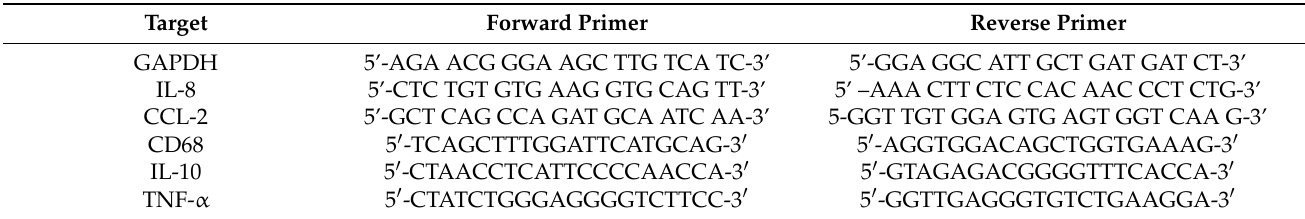
Table 1. Primer sequences for qrt-PCR